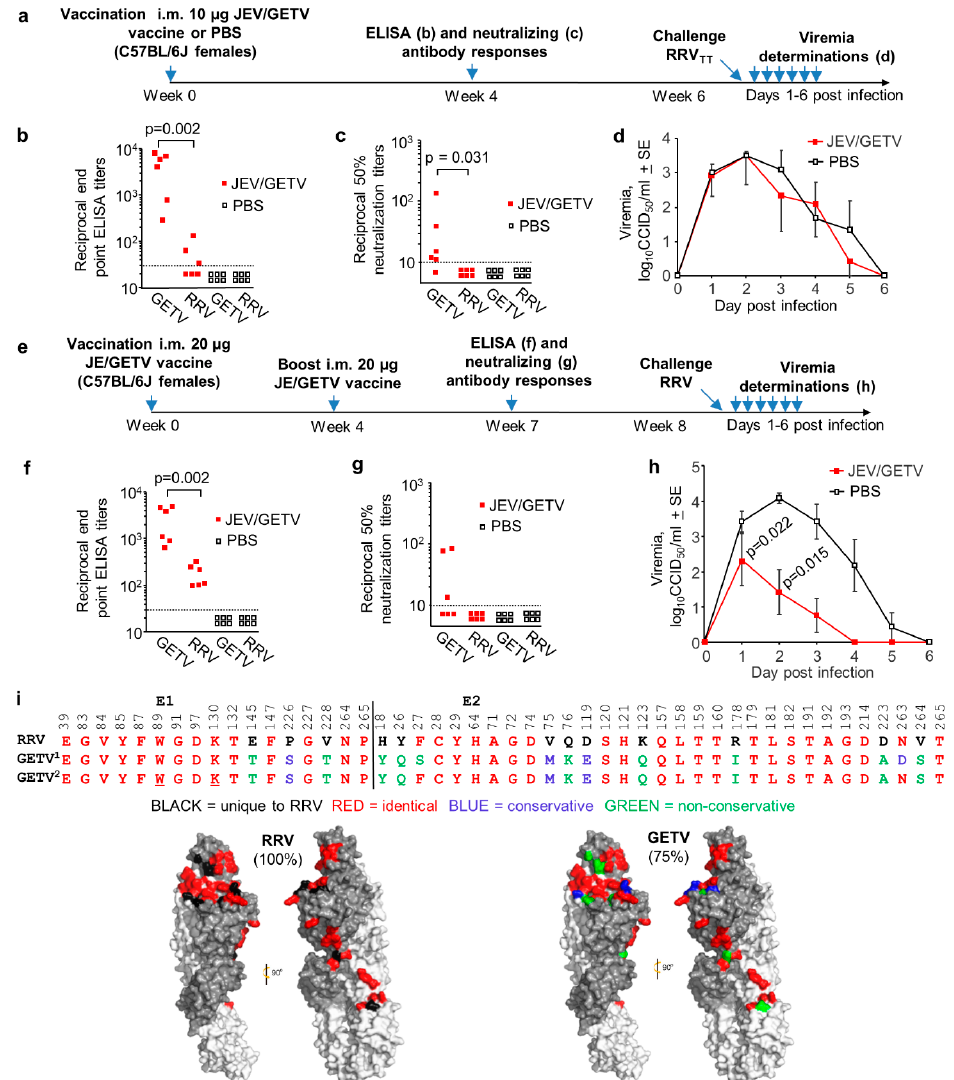
Figure 5. Cross-protection against RRV mediated by the Japanese Encephalitis (JEV)/ Getah virus (GETV) vaccine. ( a ) Timeline of the single 10 µg vaccination with JEV/GETV vaccine (the GETV vaccine strain is MI-110) or PBS, antibody measurements and RRV TT challenge; ( b ) GETV MM2021 and RRV TT endpoint IgG ELISA titers after 1 vaccination with JEV/GETV vaccine or PBS (limit of detection 1 in 30); ( c ) GETV MM2021 and RRV TT 50% neutralization titers after 1 vaccination with JEV/GETV vaccine or PBS (limit of detection 1 in 10); ( d ) RRV TT viremia post-challenge with RRV TT in mice vaccinated once with JEV/GETV vaccine or PBS (n = 6 mice per group). (Limit of detection for each mouse 2 log 10 CCID 50 /mL.); ( e ) Timeline of two 20 µg vaccinations with JEV/GETV vaccine or PBS, antibody measurements and RRV TT challenge; ( f ) GETV and RRV TT endpoint IgG ELISA titers after 2 vaccinations with JEV/GETV or PBS (limit of detection 1 in 30); ( g ) GETV MM2021 and RRV TT 50% neutralization titers after 2 vaccinations with JEV/GETV vaccine or PBS (limit of detection 1 in 10); ( h ) RRV TT viremia post-challenge with RRV TT in mice vaccinated twice with JEV/GETV vaccine or PBS (n = 6 mice per group). Statistics by Kolmogorov–Smirnov tests; ( i ) As for Figure 3a,b the 48 E1/E2-MXRA8 contact residues (based on CHIKV) are aligned for RRV TT and GETV MI-110 (GETV 1 , vaccine strain) and GETV MM2021 (GETV 2 ) E1/E2, with GETV MI-110 residues colored in the cryo-EM structures of E1 / E2. GETV MI-110 shows 75% amino acid identity in these 48 amino acids with RRV TT . The conserved, but formalin-fixation-sensitive, amino acids K and W are